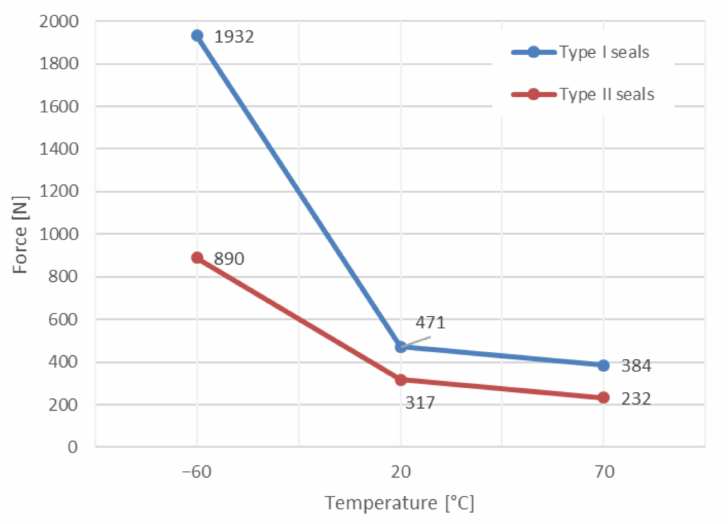
Figure 25. Type I and Type II seals closing forces for the piston with toroidal shape as a function of the